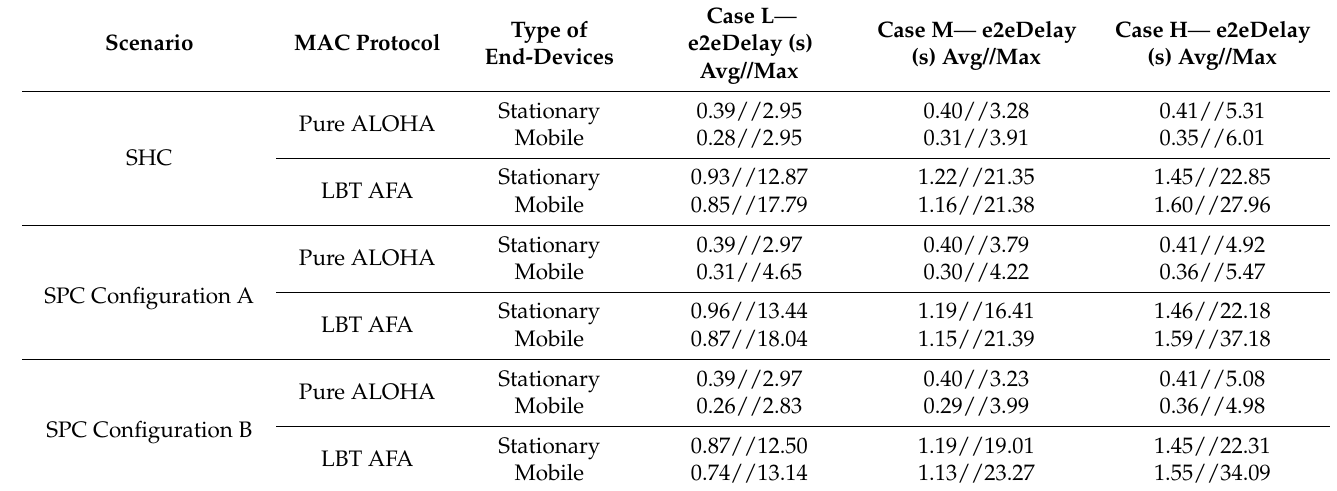
Table 10. Average and maximum e2eDelay under different traffic conditions.